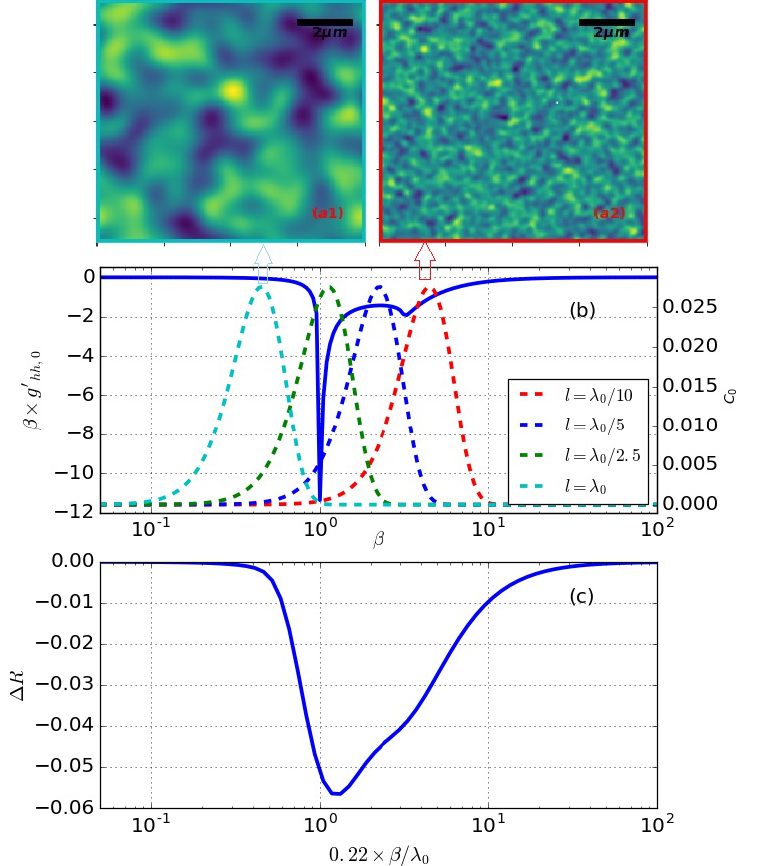
Figure 4. Illustration of C 0 functions for Gaussian surfaces overlapped with the weighting function and corresponding surface profile. The top panels ( a1 , a2 ) show two example surface height profiles. Panel ( b ) shows weighting function with four C 0 functions. Panel ( c ) shows roughness caused surface reflection change ∆ R versus the 0.22 β / l , which is the location of C 0 function